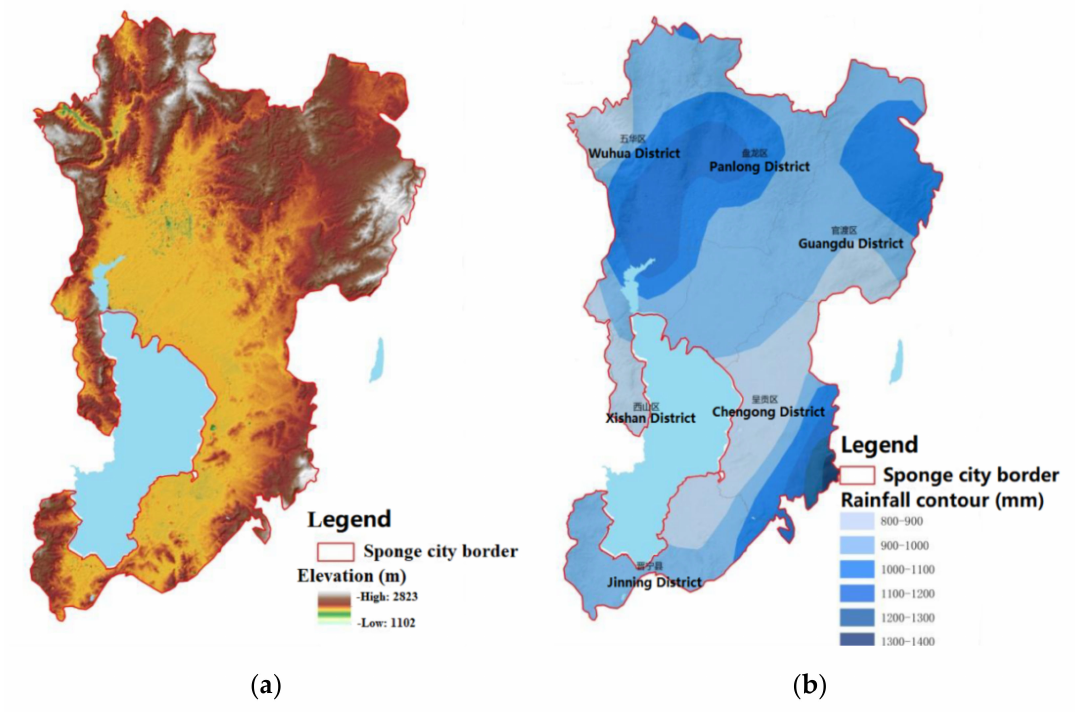
Figure 1. Map showing: ( a ) the elevation, and ( b ) the rainfall distribution in Kunming (adapted from Ref.